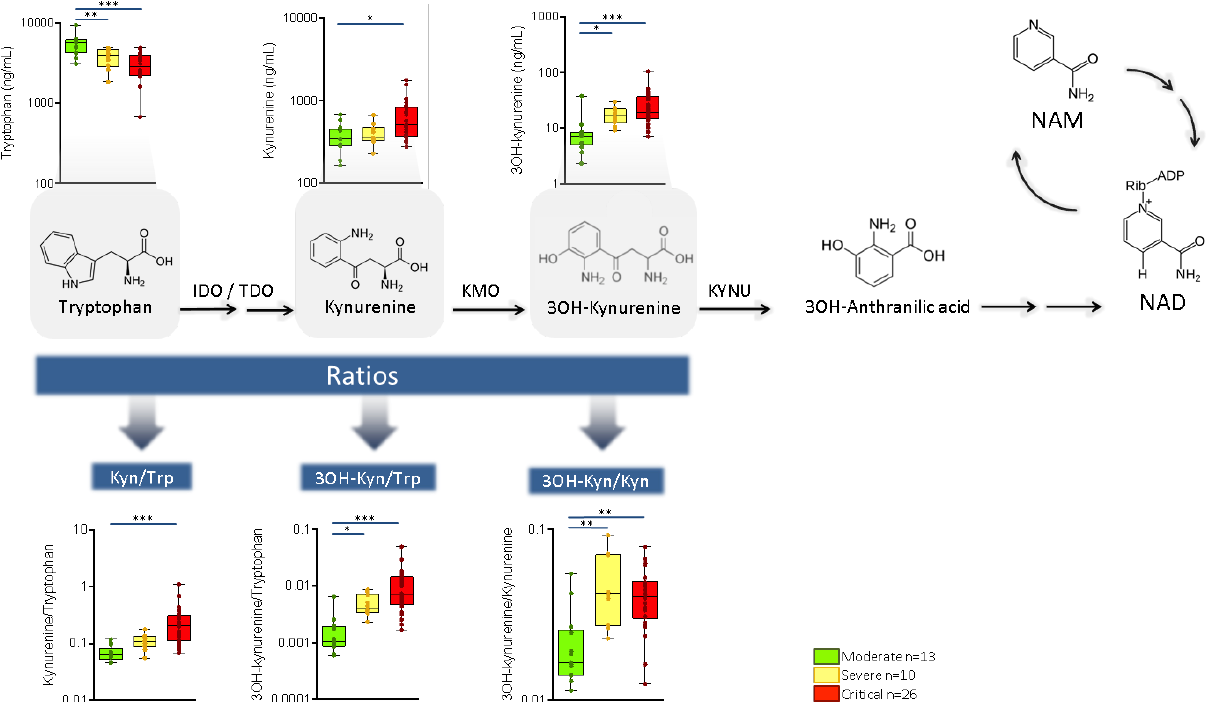
Figure 3. Metabolic pathway of the tryptophan metabolism via the kynurenine pathway in hospitalized patients with COVID-19 pneumonia. Abbreviations: IDO/TDO: indoleamine dioxygenase; KAT: kynurenine aminotransferase; KMO: kynurenine hydroxylase; KYNU: kynureninase; NAM: nicotinamide; NAD: nicotinamide adenine dinucleotide; NicA: nicotinic acid. * p ≤ 0.05, ** p ≤ 0.01, *** p ≤ 0.001.